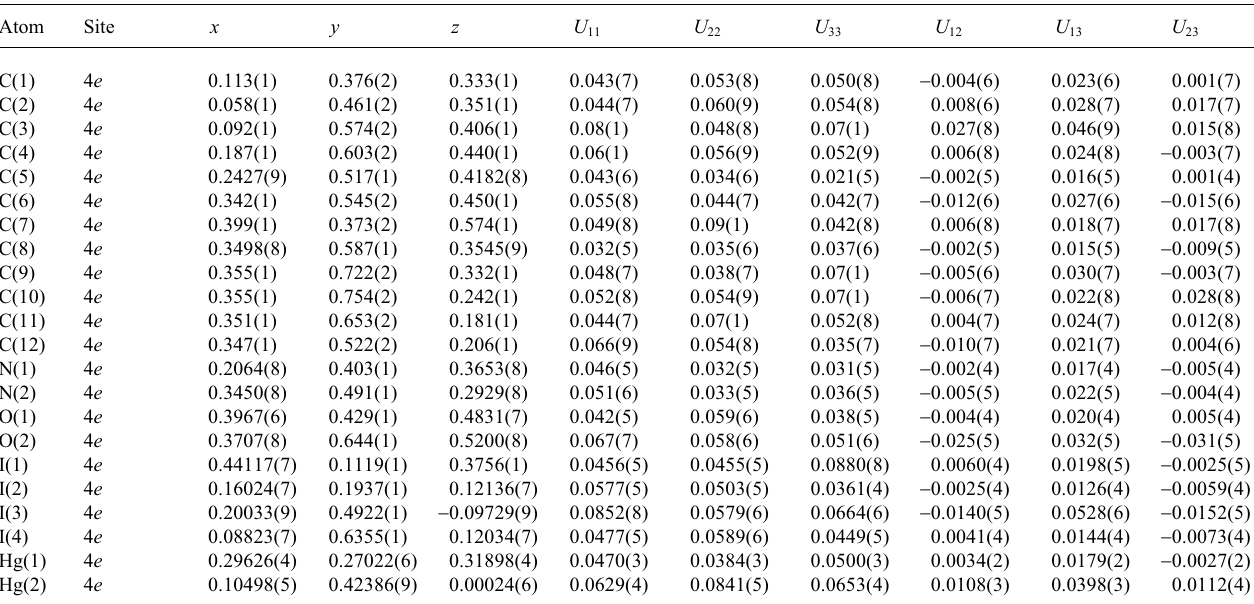
Table 3. Atomic coordinates and displacement parameters (in Å 2